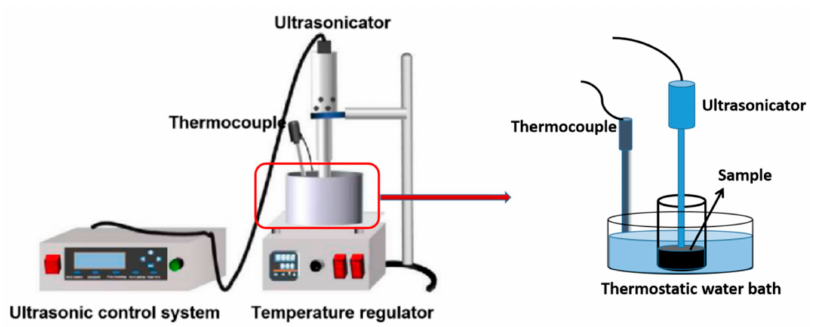
Figure 3. The ultrasonically enhanced leaching